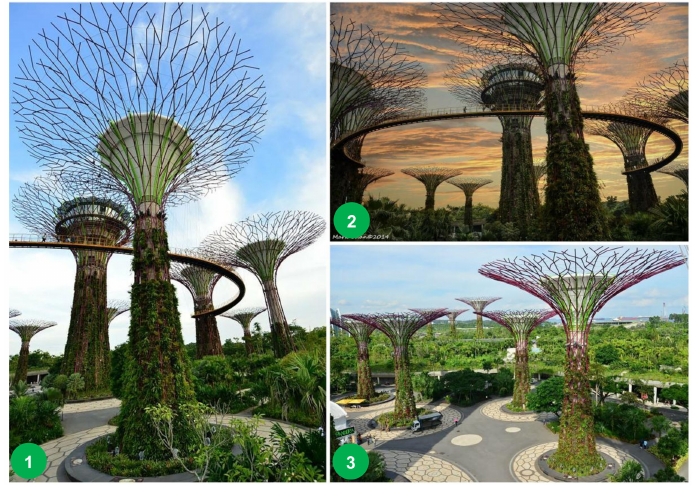
Figure 2. Singapore ‘Gardens by the Bay’: ( 1 ) Close up of the ‘Supertree Grove’, ( 2 ) Panoramic sunset view of the elevated walkway called OCBC Skyway, ( 3 ) Walking environment and scale of the gardens (Photographs taken by Mark Chan,